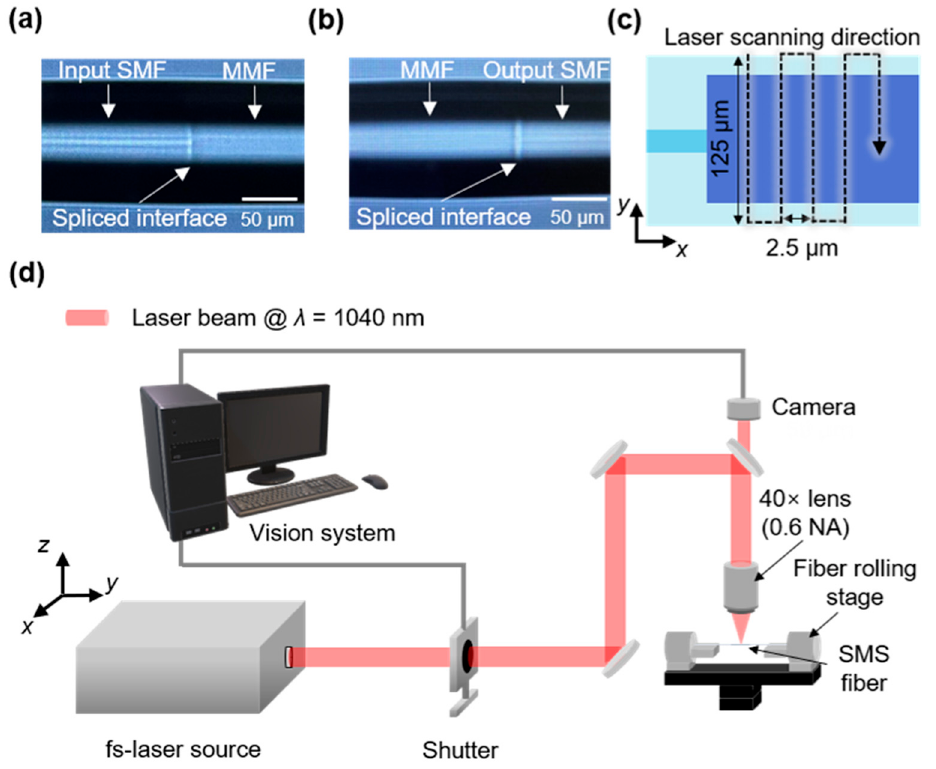
Figure 4. Optical microscope images of the splicing interfaces of the MMF: ( a ) input SMF and ( b ) output SMF. ( c ) Scanning track of the fs ‐ laser for polishing the SMS fiber in the x–y plane. ( d ) Schematic of the fs ‐ laser system used for the dual ‐ side polished SMS fiber structure.